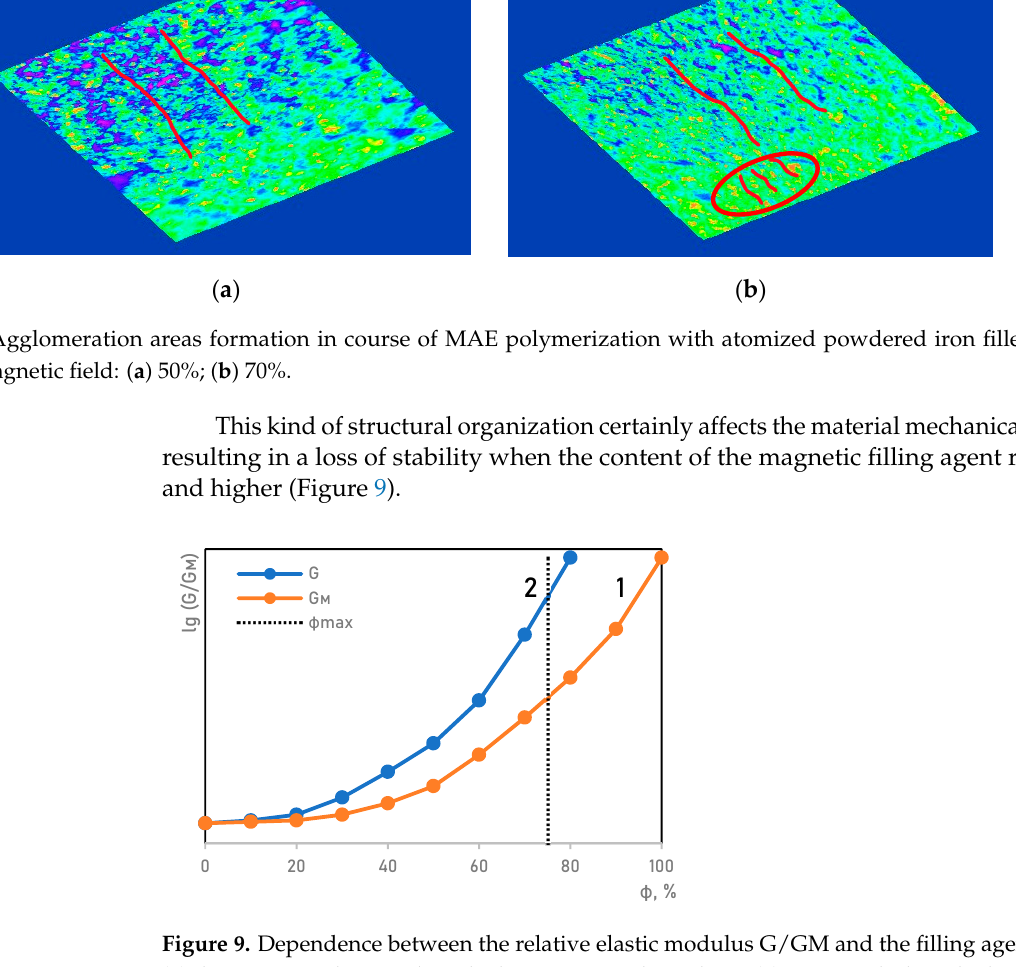
( b ) Figure 10. Assessment of MAE characteristics—elastic modulus: ( a ) samples with R-10 filler; ( b ) samples with atomized powdered iron filler.